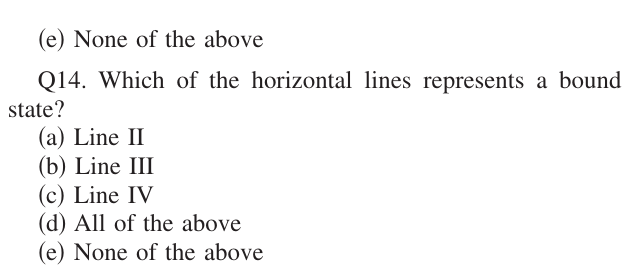
FIG. 21. Diagram of an electron entering and exiting a box.